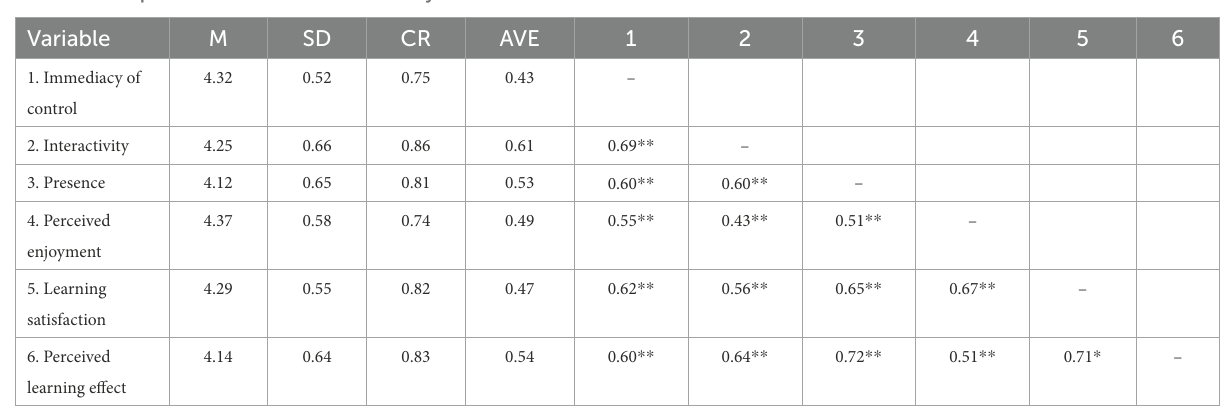
TABLE 1 Descriptive statistics and correlation analysis for each